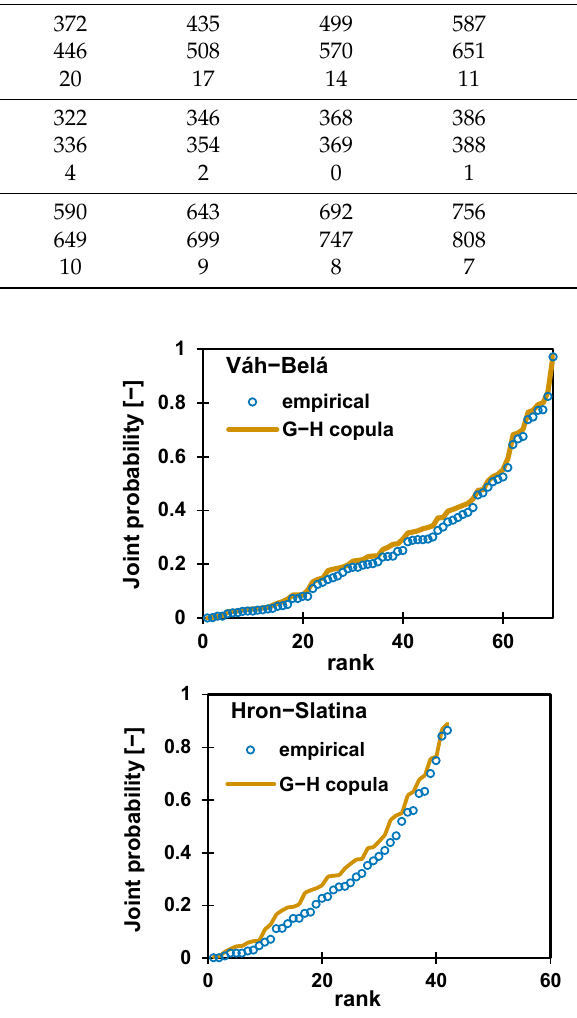
Table 4. The Gumbel–Hougaard copula parameters for the selected variable combinations, mean absolute errors (MAE) values, and K–S test.